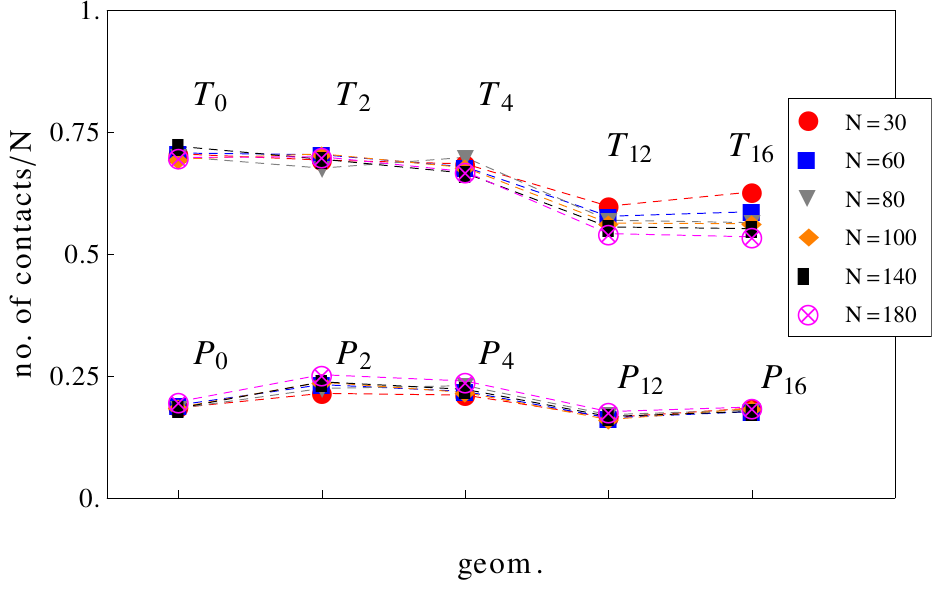
Figure 7. Average number of contacts with the walls, normalized by chain length N as a function of geometry (see Figure 1). The top curve is for applied fields with both longitudinal and transversal components, and the bottom curve is for fields parallel to the symmetry